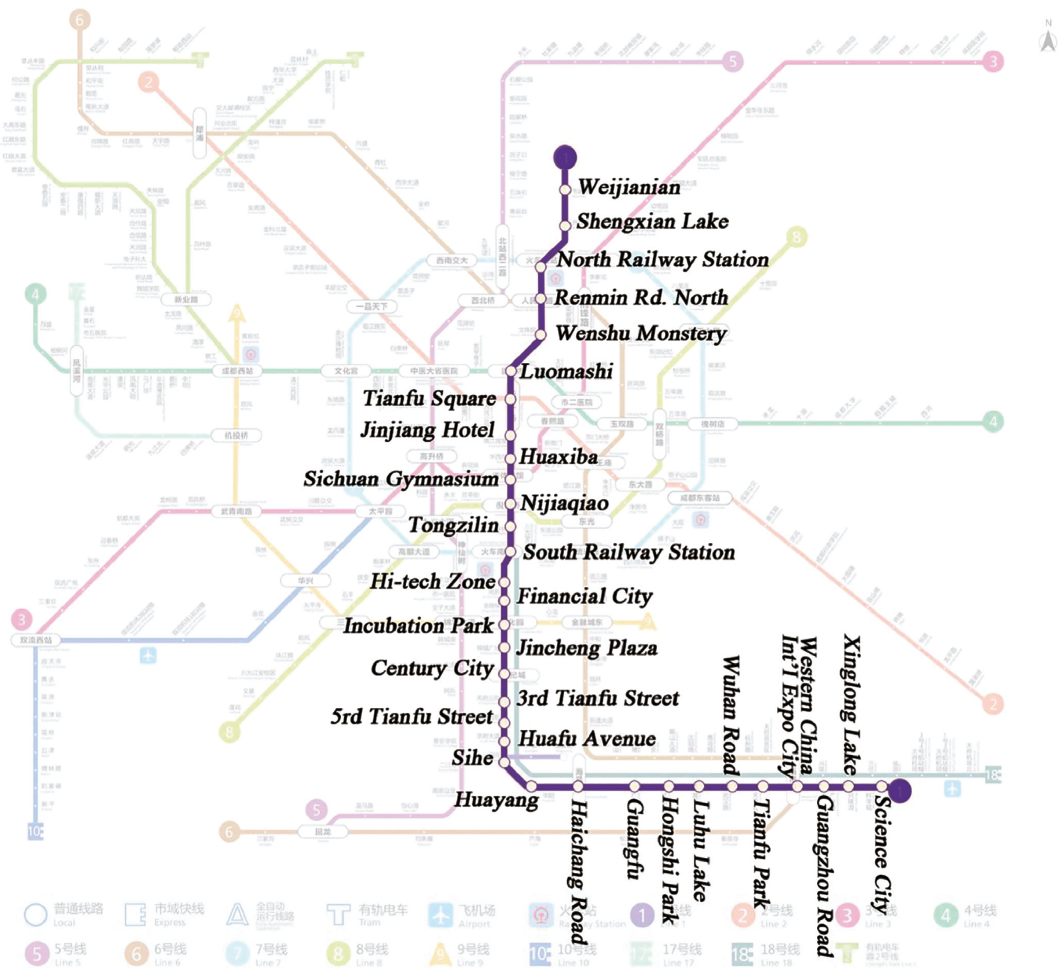
Figure 8: Illustration of the Chengdu Metro network and Line No 1. Table 2: Samples of information on Chengdu Line No. 1 (in part). Section